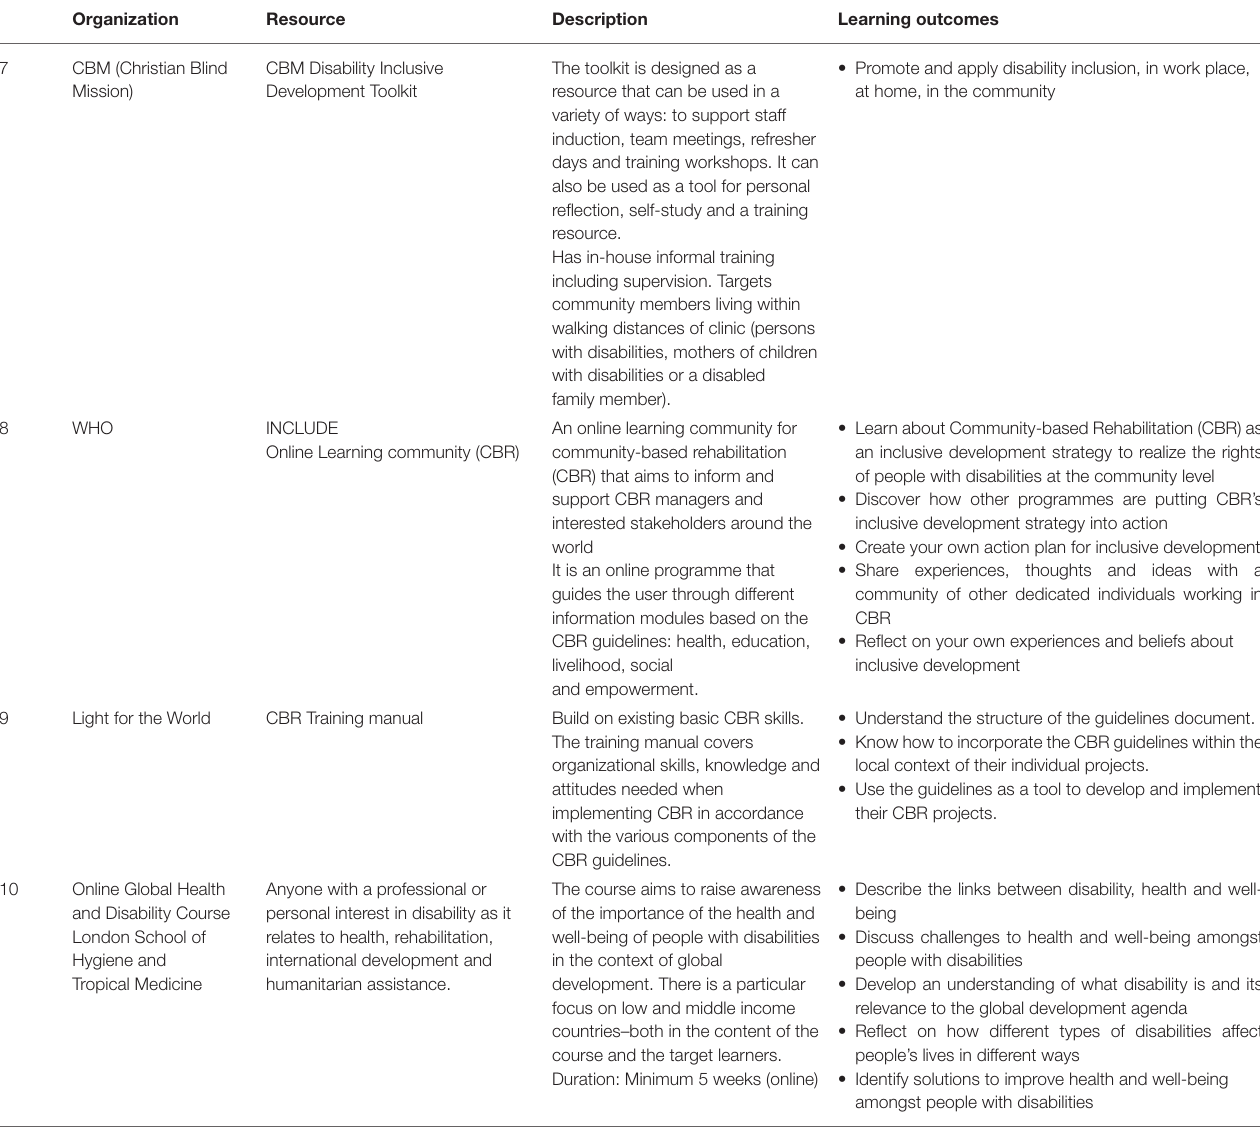
TABLE 2 | Other informal open source online training and training resources